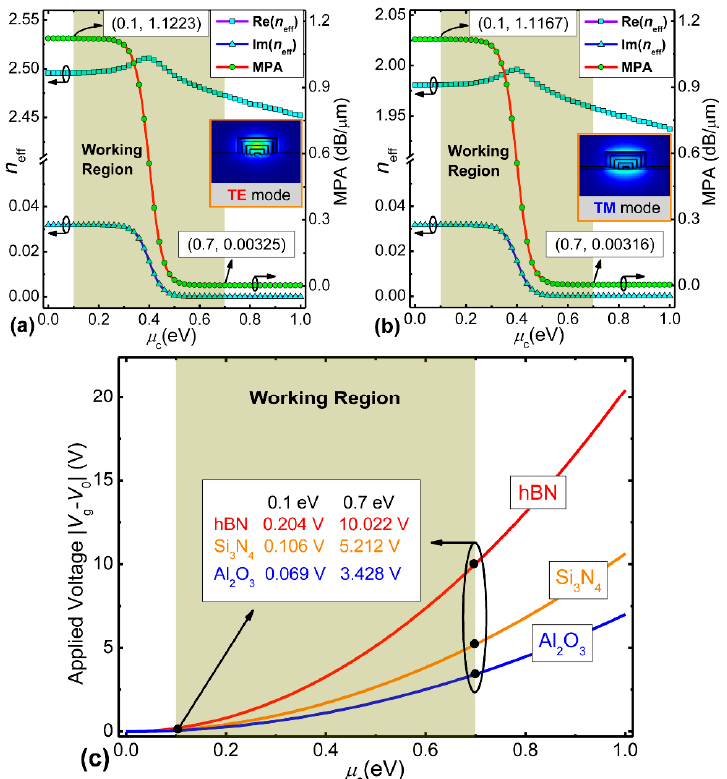
Figure 2. Modal properties of both polarization modes and applied voltages on the graphene flake. Real (Re( n eff )) and imaginary (Im( n eff )) parts of effective modal index of the hybrid graphene-silicon waveguide and the MPA versus chemical potential ( µ c ) of graphene for ( a ) transverse electric (TE) mode and ( b ) transverse magnetic (TM) mode. The insets show the electric field profiles (dominant component) at µ c = 0.7 eV. ( c ) Applied voltage (| V g − V 0 |) of the hybrid graphene-silicon waveguide as a function of the graphene chemical potential ( µ c ) for different spacer and insulating materials (Al 2 O 3 , Si 3 N 4 , hBN). The inset calculates the applied voltages for three different spacer and insulating materials at µ c = 0.1 eV and 0.7 eV.